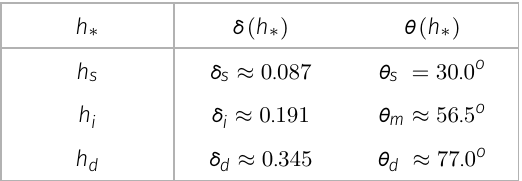
Table I. based on CCCDF summarizes the limits between the regions here established as normalized shallow depth h s ≈ 0 . 275 h s ≈ 0 . 275 h s ≈ 0 . 275 , intermediate depth at h i = 1 h i = 1 h i = 1 and deep waters a part from h d ≈ 2 . 11 h d ≈ 2 . 11 h d ≈ 2 . 11 respectively. Besides, it is also shown the ratio δ = d / λδ = d / λδ = d / λ and the refraction angle θθθ related to these